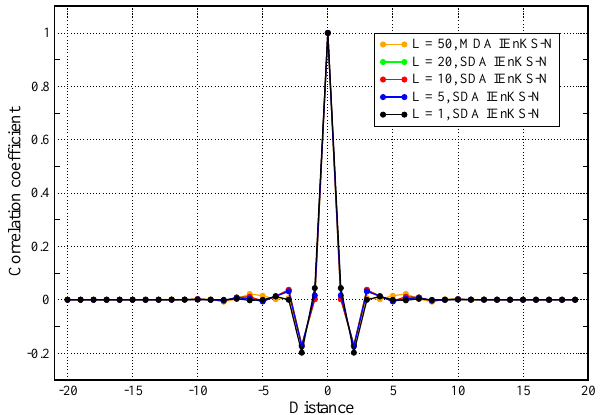
Fig. 12. Structure function of the correlation of the errors of the initial condition in the IEnKS, for several DAW lengths.